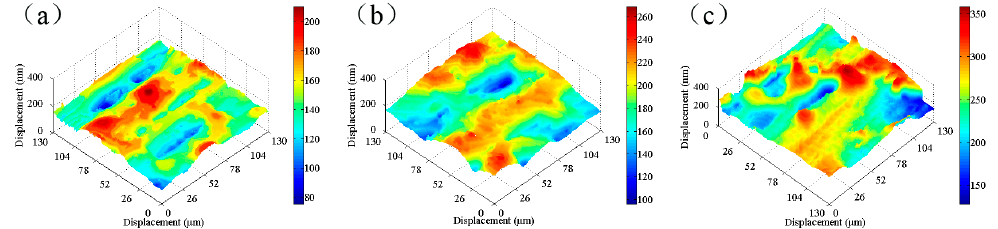
Figure 3. Geometrical topography of tinplate treated with ( a ) reflowing before passivation, ( b ) chemical passivation, and ( c ) electrolytic passivation. Table 1. Surface roughness ( R a , nm) values of tinplate samples treated with different processes. Tinplate